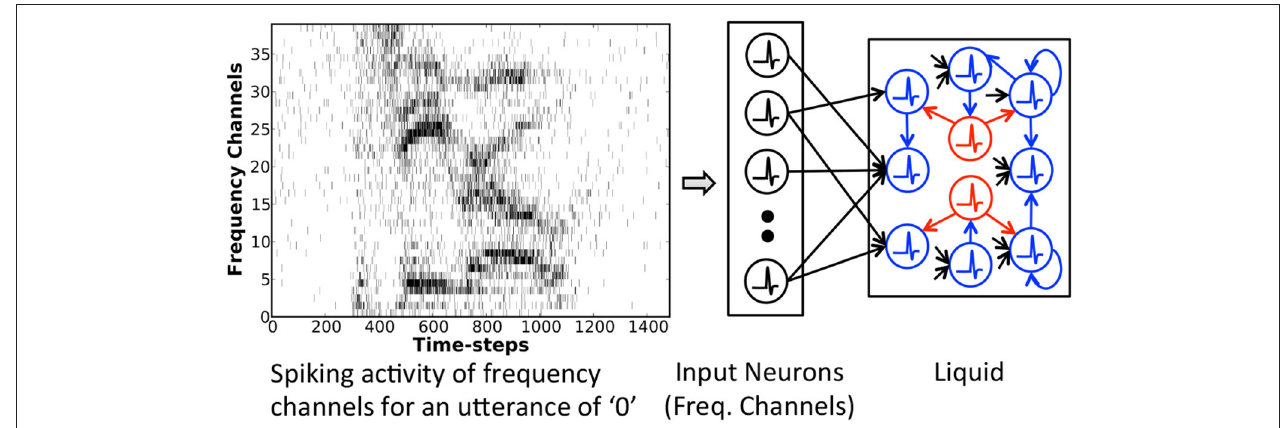
FIGURE 2 | Single-layered Liquid-SNN consisting of input neurons (represented by the time evolution of frequency channels characterizing an utterance of “0” in this sample illustration) sparsely connected to a liquid housing excitatory (highlighted in blue) and inhibitory (highlighted in red) neurons recurrently interlinked in a sparse random